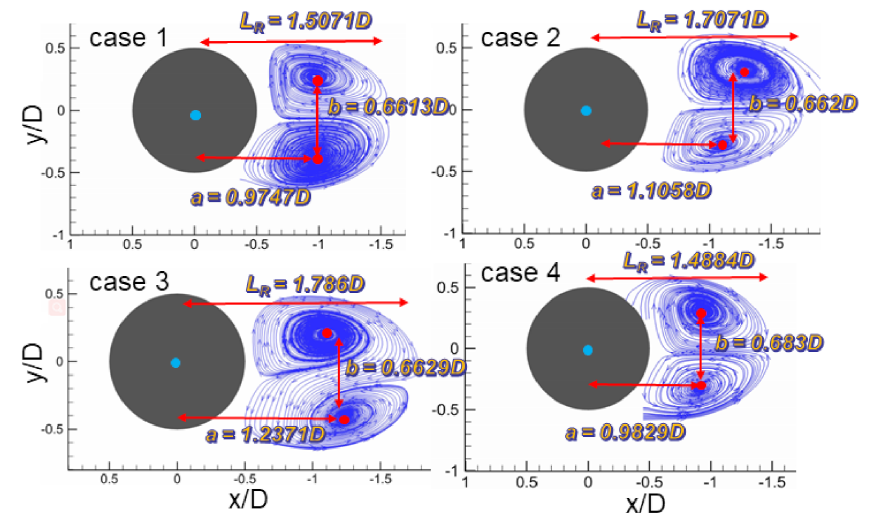
Figure 9. The streamline patterns and mean velocity vector plot for the smooth cylinder and the dimpled cylinder with different numbers.